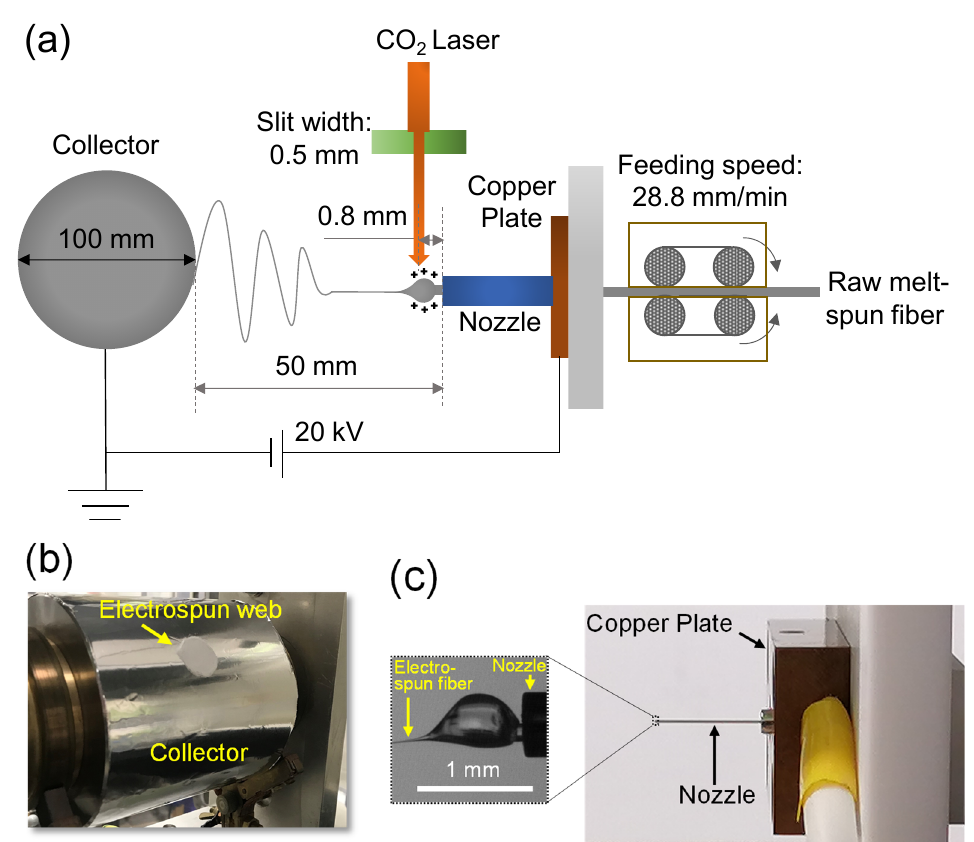
Figure 1. ( a ) Schematic of laser electrospinning (LES), ( b ) image of collector section of LES with web prepared under the stationary state of the collector, and ( c ) image of nozzle section of LES apparatus with an enlarged photograph showing typical spinning behavior.